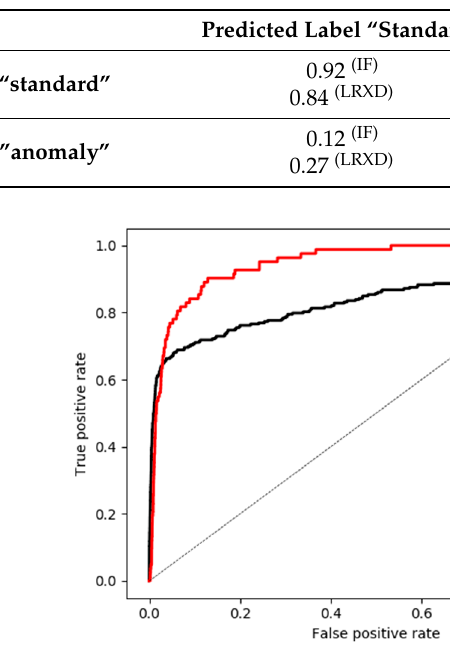
Table 3. Normalized confusion matrix for Isolation Forest (IF) and local Reed–Xiaoli detector (LRXD) anomaly detection of submerged structures.